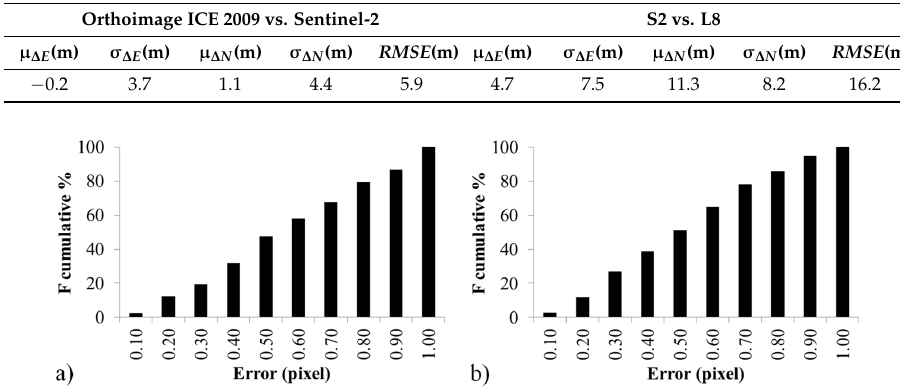
Table 5. Errors statistics: mean and standard deviation of E and N differences, Root Mean Squared Error ( RMSE ). (left) Absolute positioning statistics (S2 vs. ICE). (right) Relative positioning statistics (S2 vs. L8).